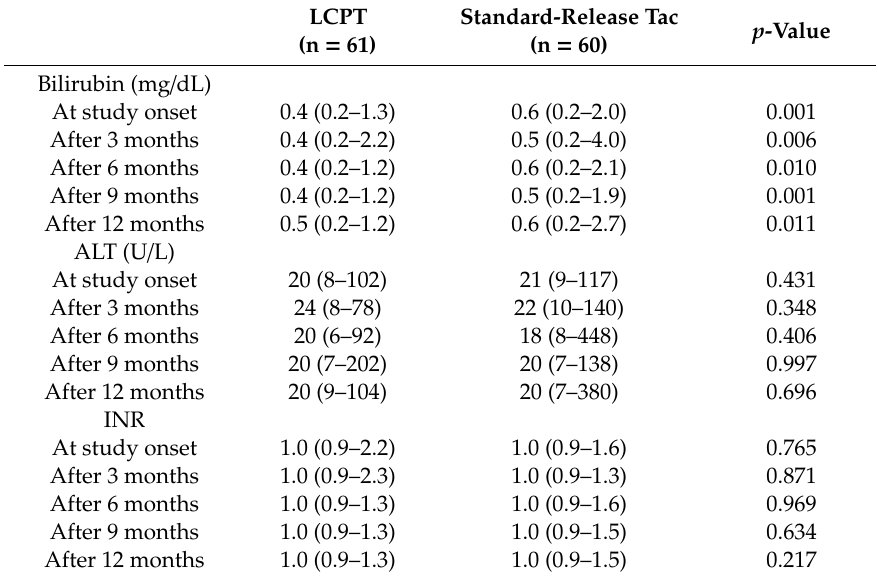
Table 7. Assessment of liver function over time in each study